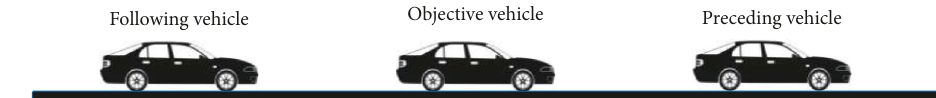
Figure 7: Traditional training data considering the effect of the following vehicle.